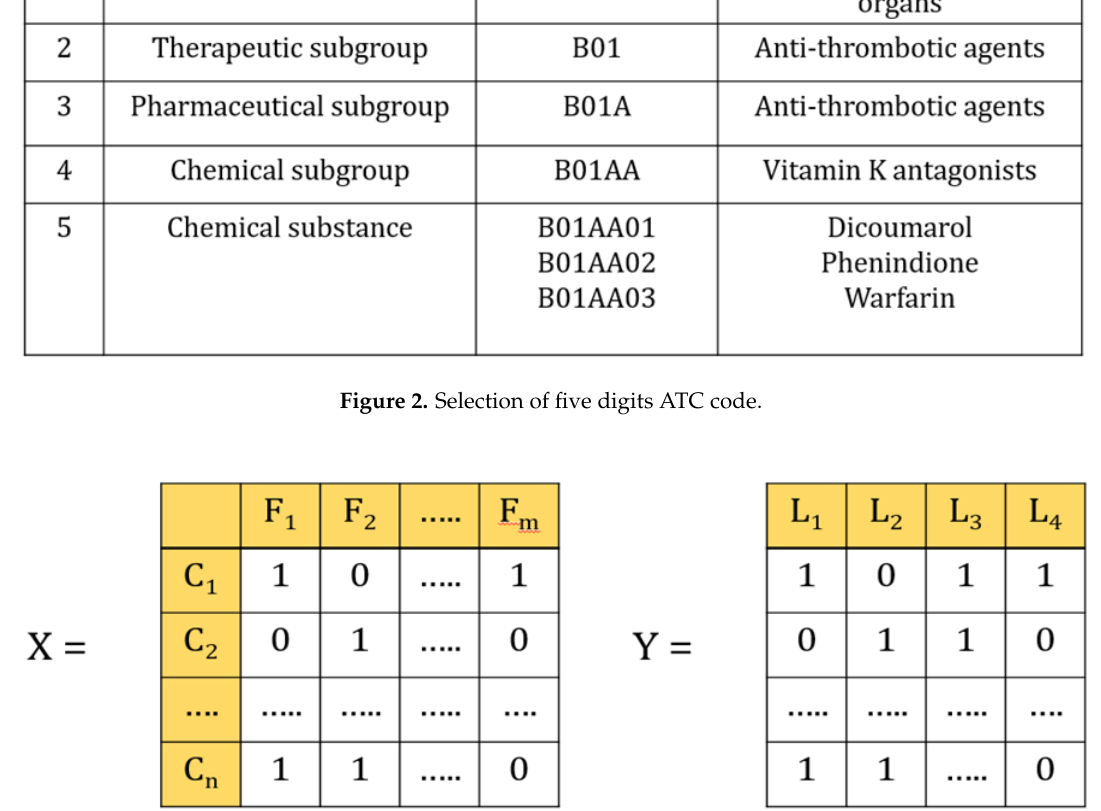
Figure 3. Illustrations of multi-label classification. X is the data set in which feature vectors represent patients C 1 –C n ; n is the number of patients; F 1 –F m are variables; m is the number of variables. Y is the label vector; L 1 –L 4 represents the number of lab tests.